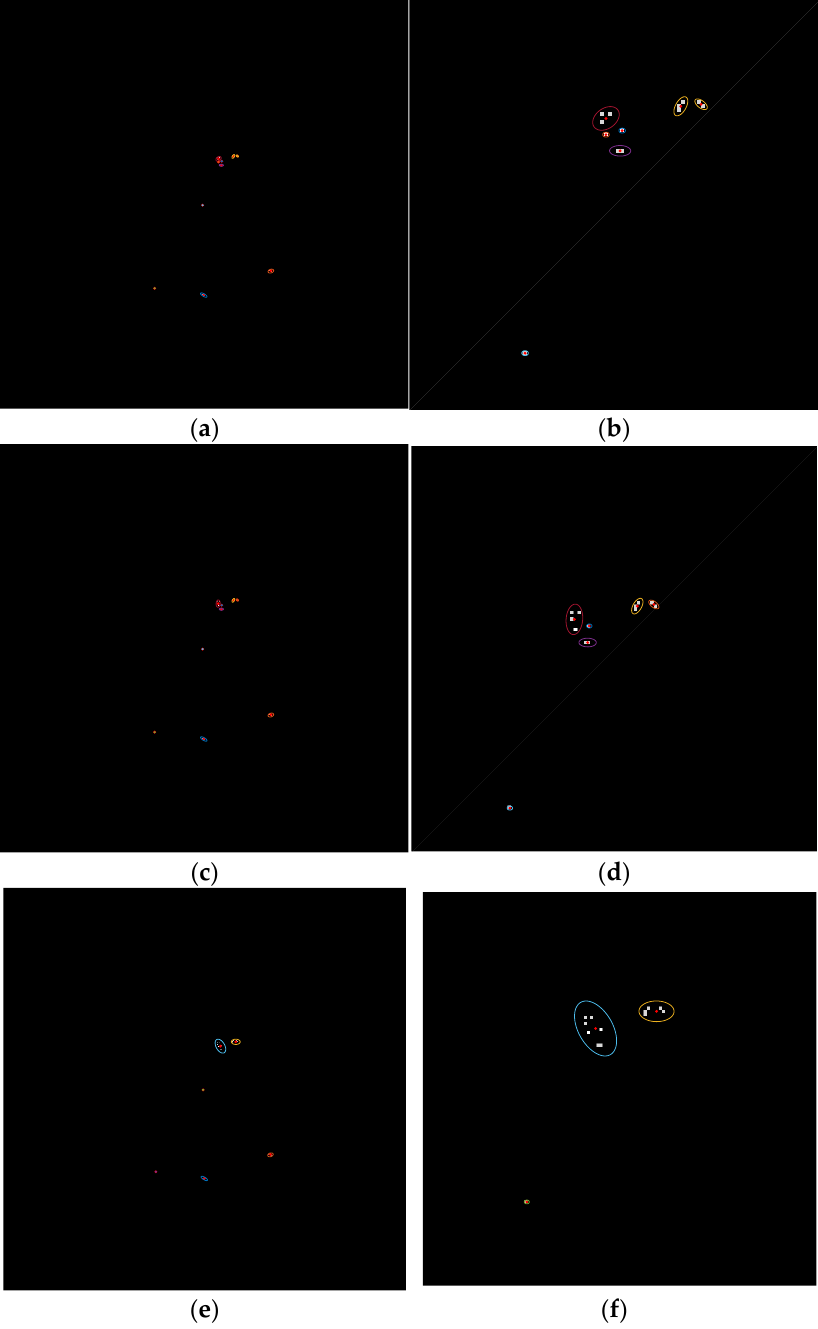
Figure 1. The partitioning results, corresponding to three different distance thresholds. ( a ) the original image (partition distance/pixel: 2.5); ( b ) the enlarged image of ( a ); ( c ) the original image (partition distance/pixel: 4.5); ( d ) the enlarged image of ( c ); ( e ) the original image (partition distance/pixel: 8.2); ( f ) the enlarged image of ( e